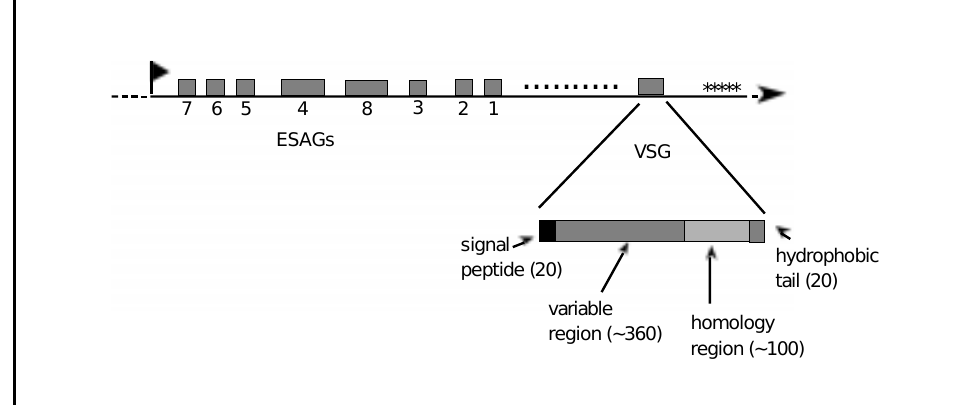
Figure 2 - The T. brucei VSG mol- ecule and a VSG gene expres- sion site. Studies of several vsg loci indicate that expression sites of bloodstream forms are organized similarly to the sche- matic representation shown, in which shaded boxes represent one VSG gene and several ESAGs. The flag indicates the promoter, the numbers below the boxes define each ESAG, the small dots and asterisks rep- resent the 70-bp (or 76-bp) re- peats and telomeric hexanucle- otide repeats, respectively, and the arrowhead indicates the chromosome terminus. The dis- tance between the VSG gene and the start of the repetitive telomeric sequence is 1-3 kb. The enlargement below fea- tures a diagram with the differ- ent regions of a nascent VSG (numbers in parentheses indi- cate the number of amino acids in each portion of